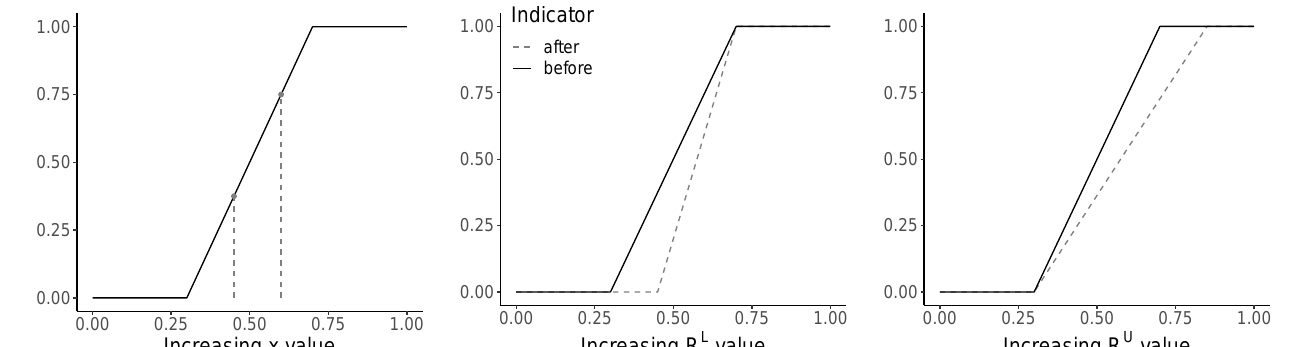
Figure 2. Special case of the behavior of the academic performance indicator P A by increasing the value of each of its variables 0.15.